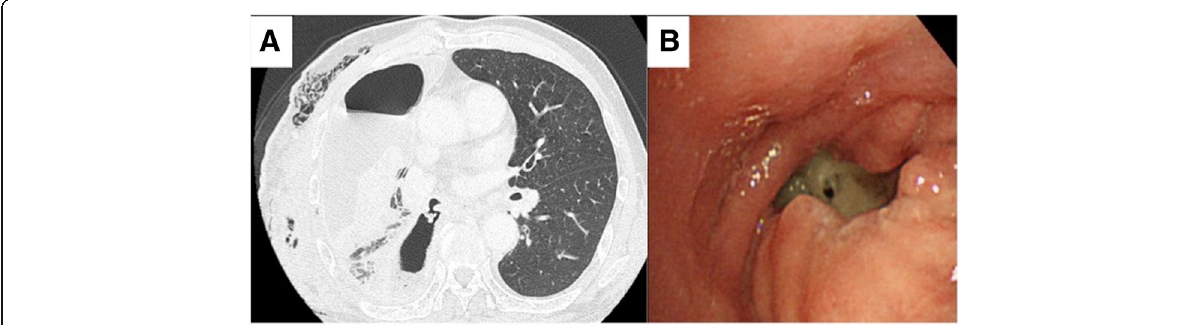
Fig. 1 Detection of the bronchopleural fistula (BPF) via bronchoscopy and computed tomography (CT). a Chest CT showed the BPF but no aspiration pneumonia. b Bronchoscopy showed the BPF at the right lower bronchial